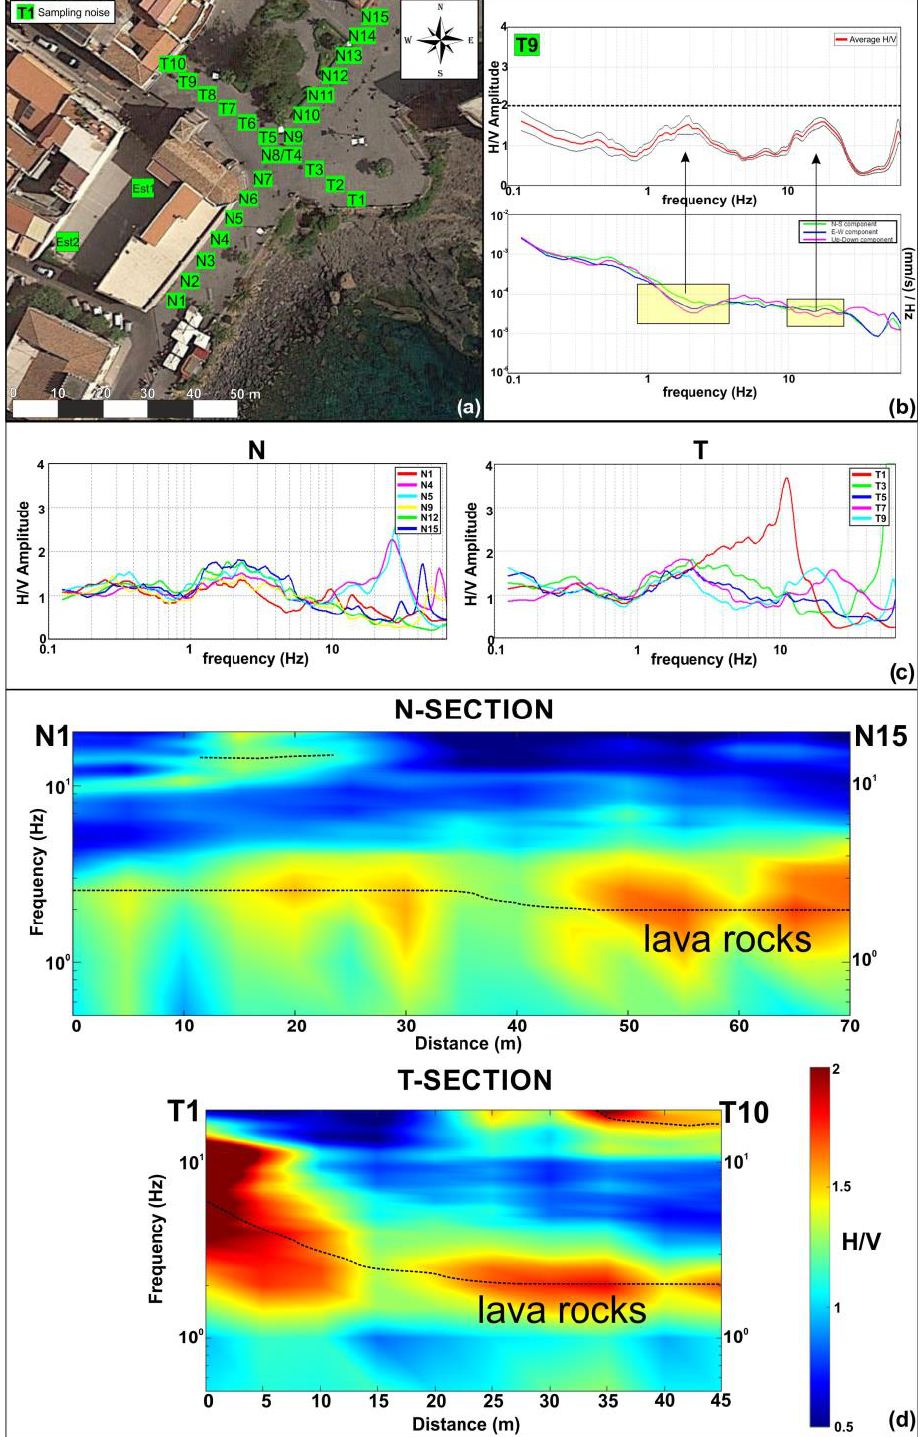
Figure 7. ( a ) Position of the ambient noise samplings; ( b ) example of H/V spectrum performed in T9 position and graph of spectral amplitude components, the yellow areas indicating the typical “eye-shape” linked to stratigraphical transitions; ( c ) examples of H/V spectra related to ambient noise samplings performed along the two alignments; ( d ) 2D diagrams obtained along the two alignments ( a ), showing the distribution of the H/V amplitude values as a function of distance ( x -axis) and frequency ( y -axis, range 0.1 – 20 Hz).